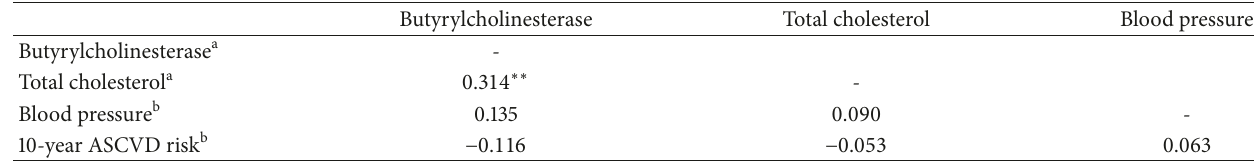
Table 3: Overall correlations among markers of organophosphate exposure and CVD risk.